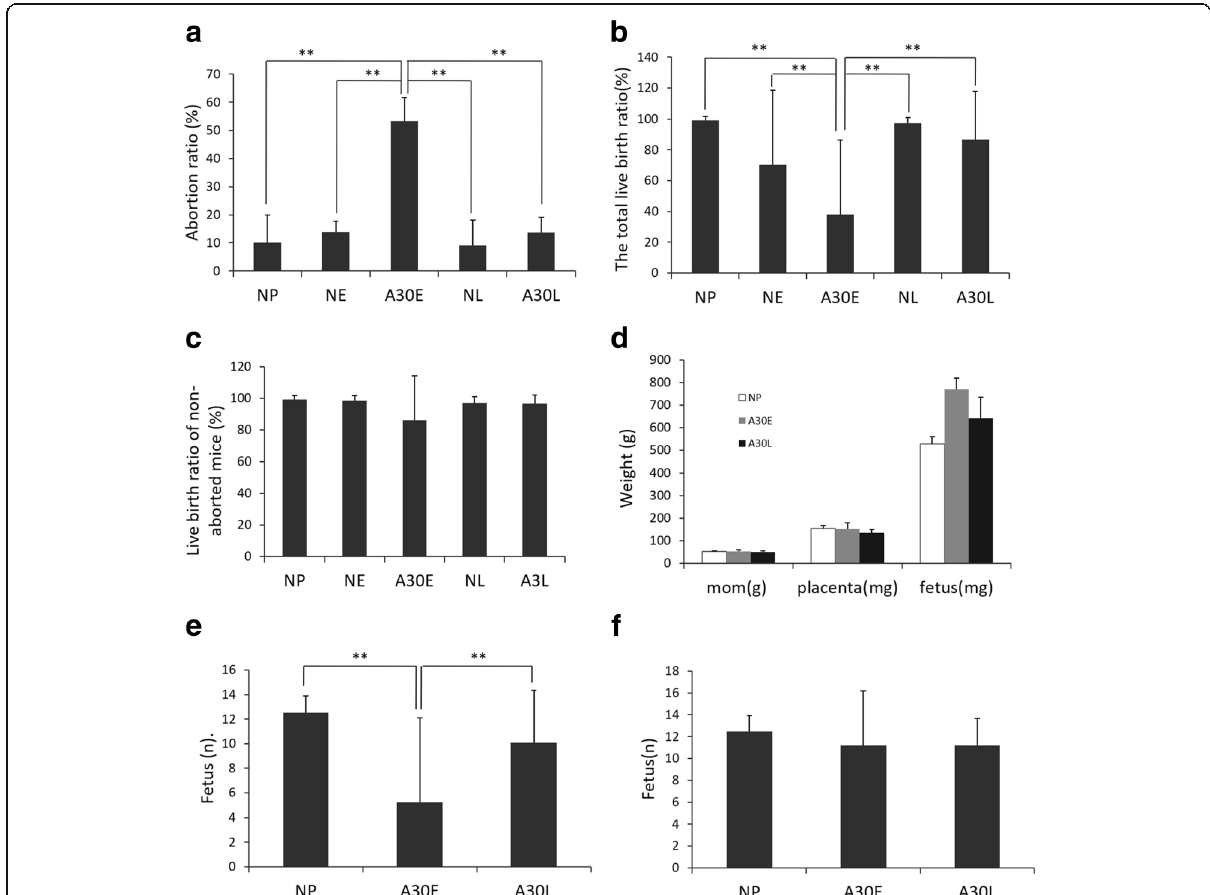
Fig. 2 Effects of A30 exposure at different gestational ages on abortion rate and fetal survival. a Abortion rate is the ratio of the number of aborted mice to the total number of pregnant mice in a group ( n = 10 per group, three independent experiments). b Total live birth rate is the ratio of the surviving embryo to the total embryos of a pregnant mice (n = 10 per group). c Live birth rate in the non-aborted mice is the ratio of the surviving embryos to the total embryos in a non-aborted pregnant mouse ( n = 5 – 10 per group). d The mean of maternal, placental and fetal weights of non-aborted pregnant mice at E16.5 ( n = 5 – 10 per group). e The mean number of fetuses per dam ( n = 10 per group). f The mean number of viable fetuses in non-aborted pregnant mice ( n = 5 – 10 per group). Data are shown as mean ± s.d. The symbol ** represents p <